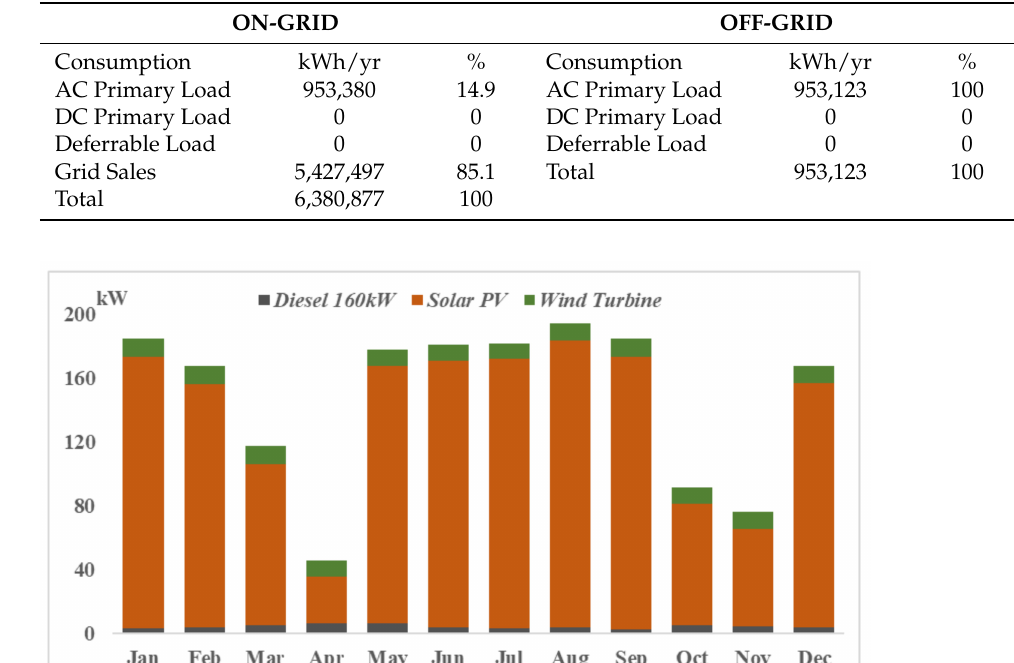
Table 4. Annual electricity consumption.